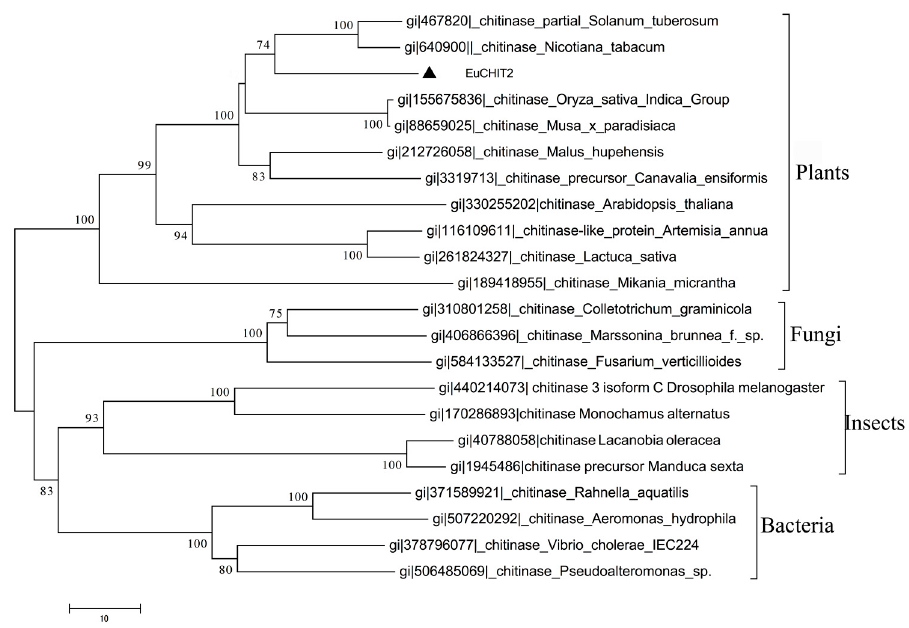
Figure 2. Phylogenetic analyze on the alignment of deduced EuCHIT2 amino acid sequences with chitinase from plants, bacteria, fungi, and insects. EuCHIT2 formed a cluster with the chitinases origin from plants and shares a closer relationship with the chitinases of S. tuberosum and N. tabacum .